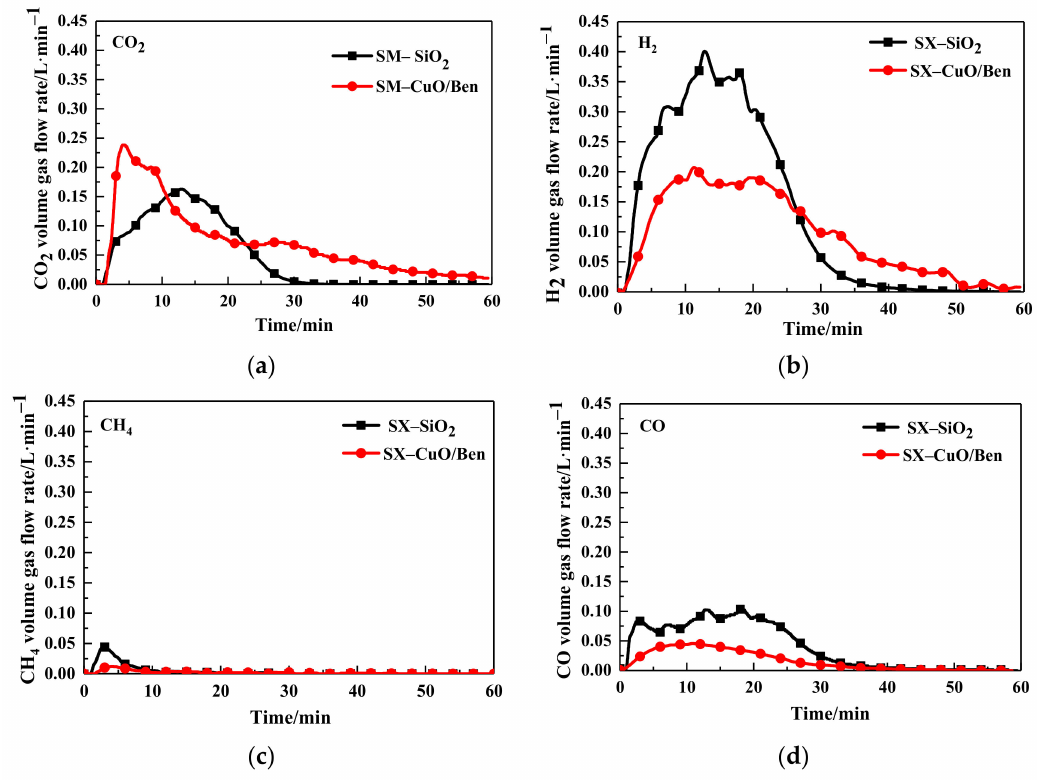
Figure 2. Gas concentration of ( a ) CO 2 , ( b ) H 2 , ( c ) CH 4 , ( d ) CO, and using SX bitumite for quartz sand and CuO/Ben oxygen